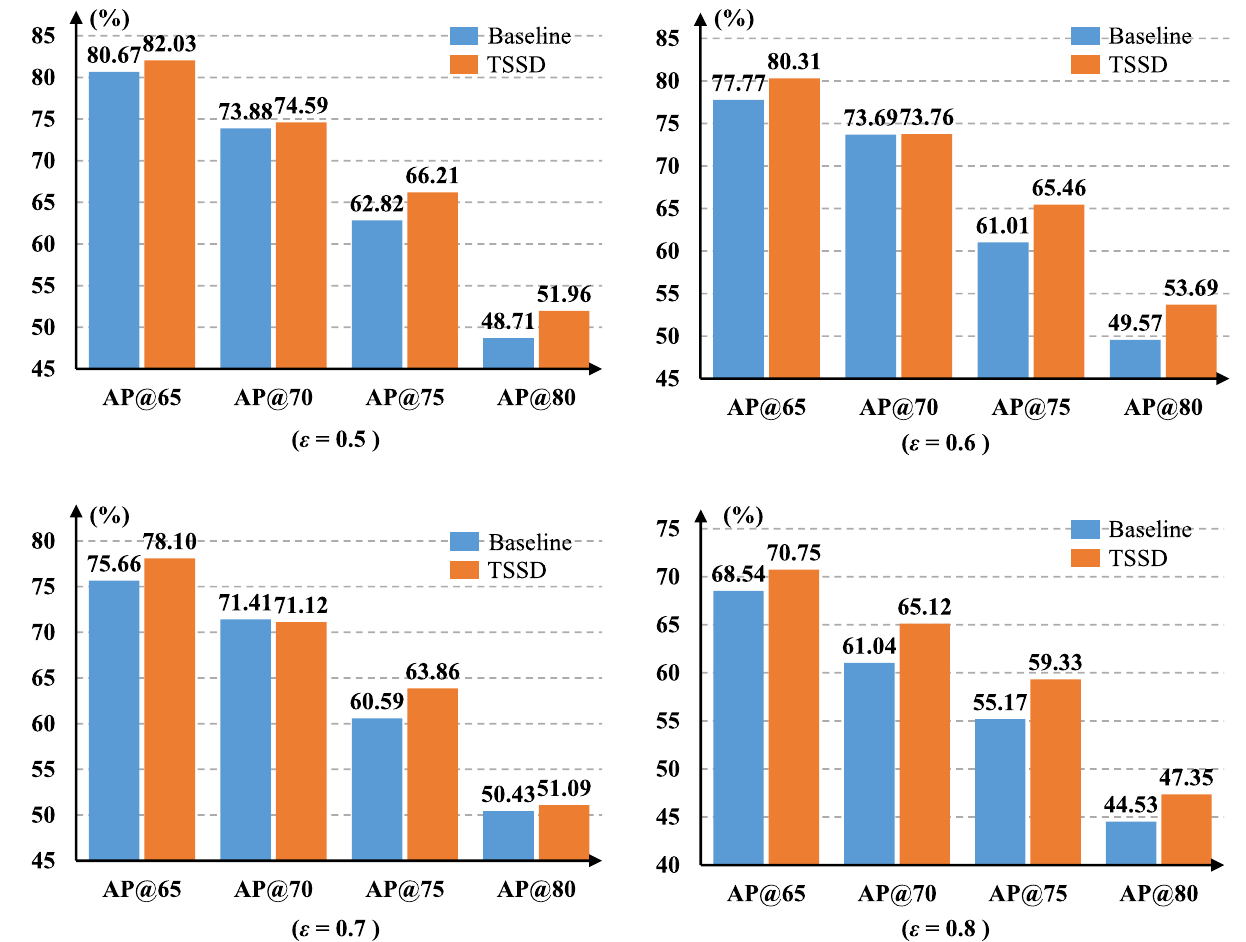
Figure 7. Comparison of the accuracy between TSSD algorithm and the baseline model at different ε